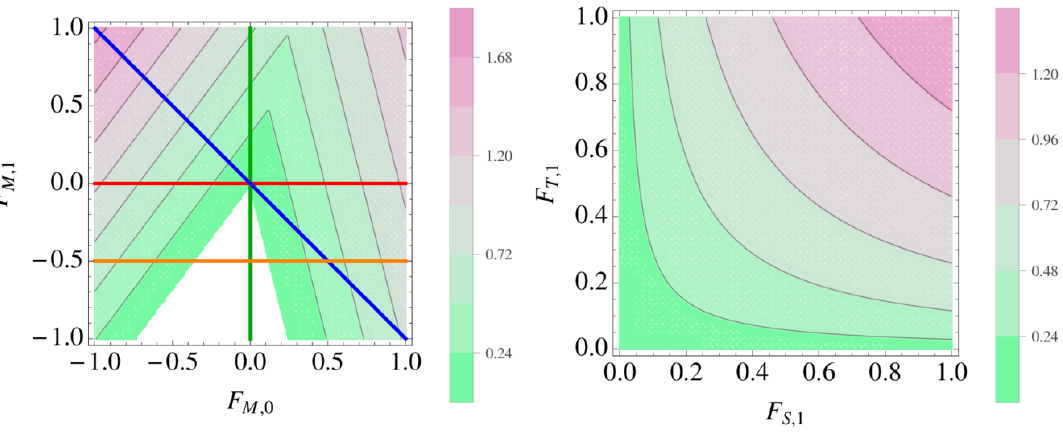
Figure 18 . Contour plots for eqs. (4.19) and (4.20), which describes the quadratic inequality from the WW channel, in the subspace of F S; 1 , F T; 1 , F M; 0 and F M; 1 .